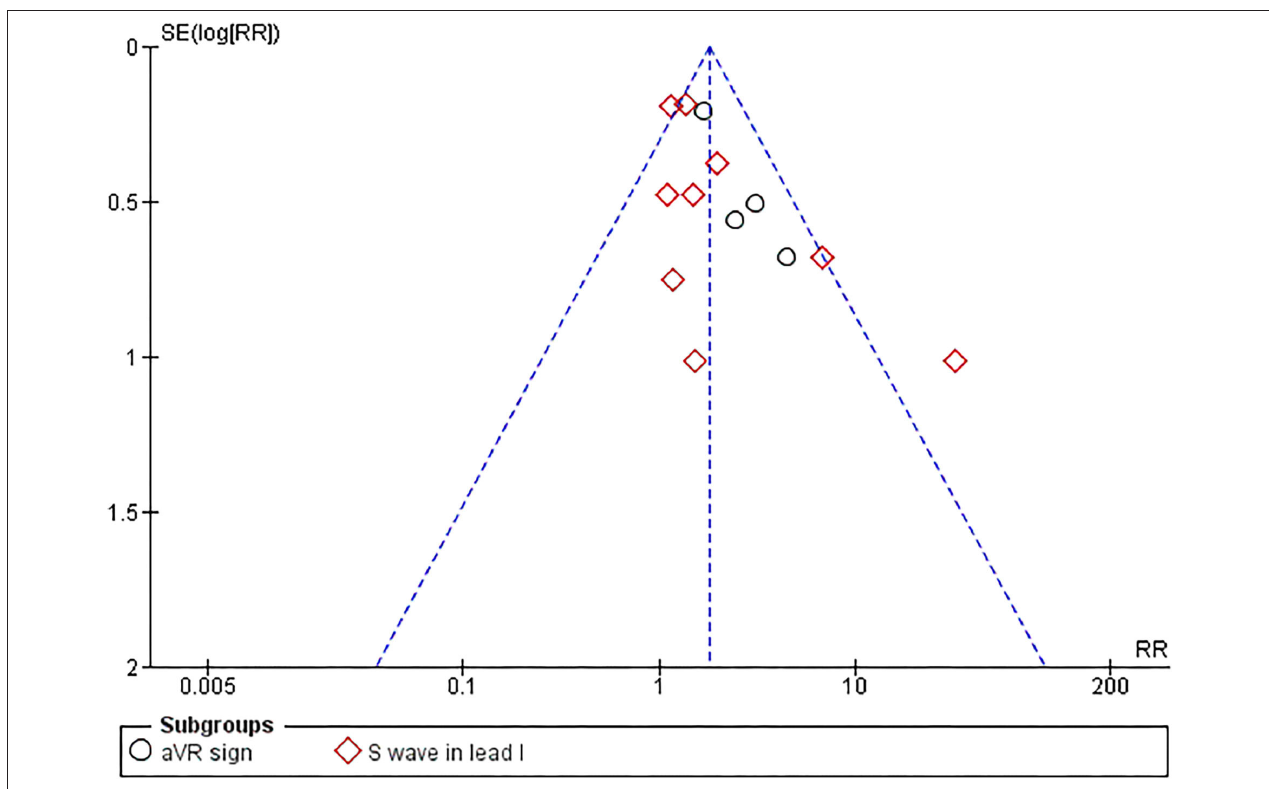
FIGURE 4 | Begg’s funnel